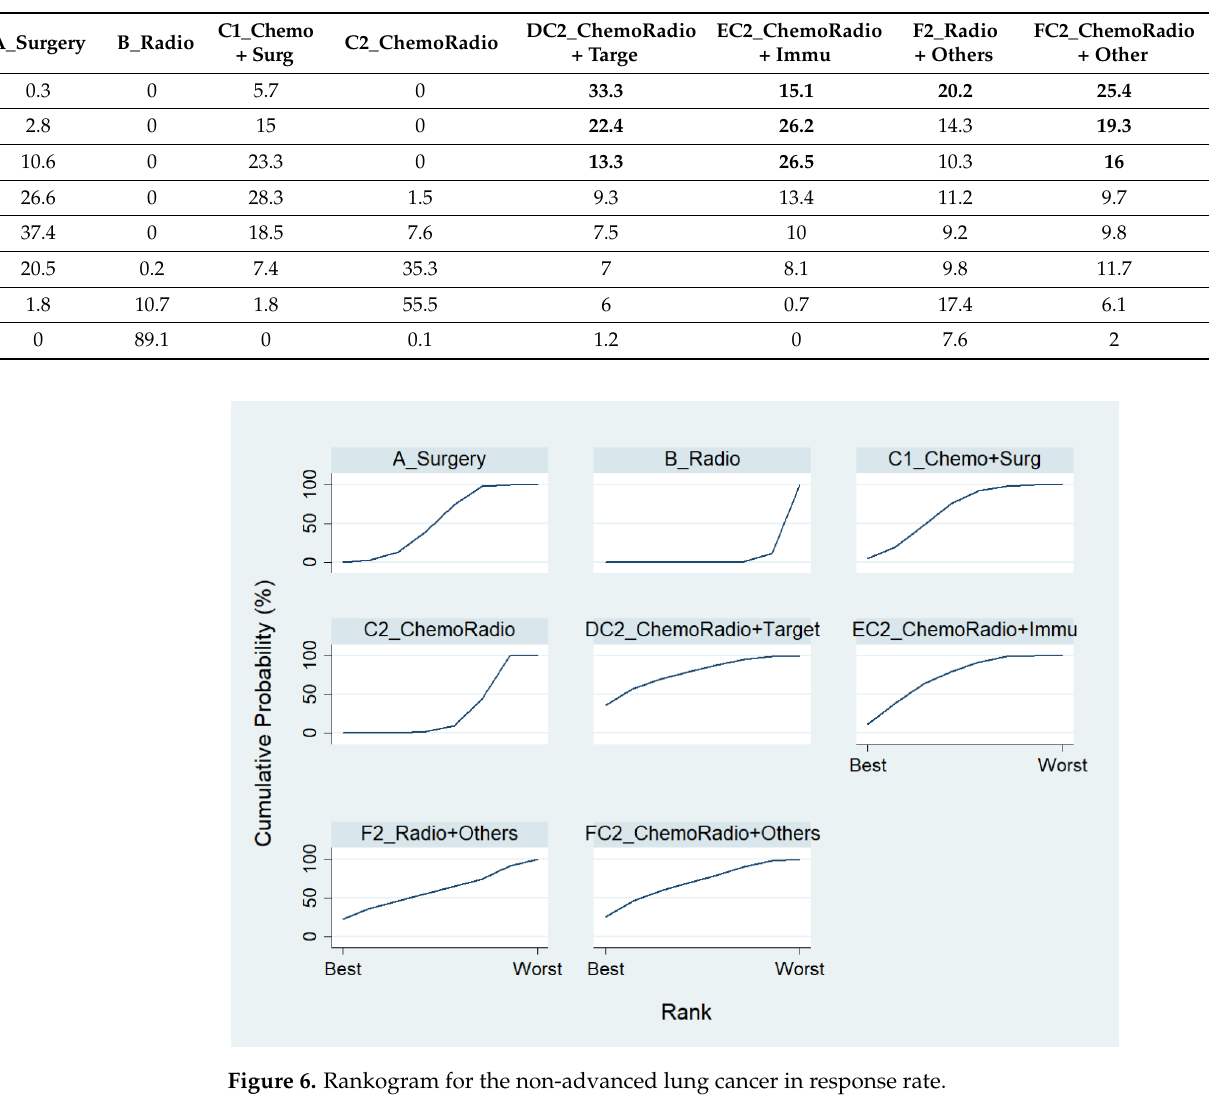
Table 4. Estimated cumulative probabilities (%) of each treatment being the best in response rate (Non-advanced stage, Component II).